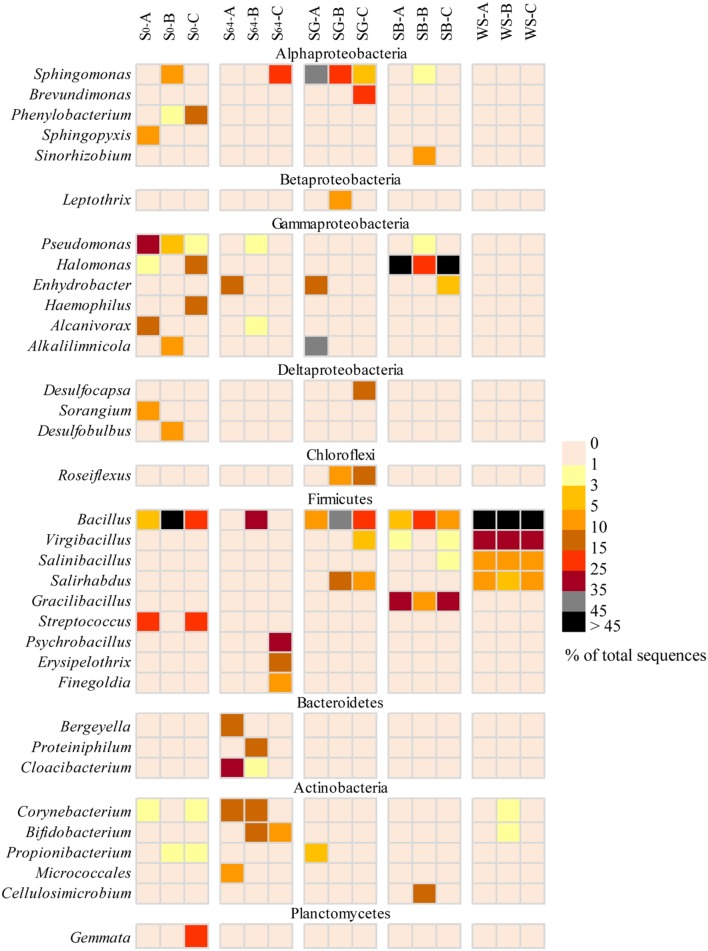
Heatmap representing a comparison of the relative abundance (% of total sequences) of the major bacterial genera in the most dominant bacterial groups in the different soils. The triplicates of each soil are denoted as A–C.